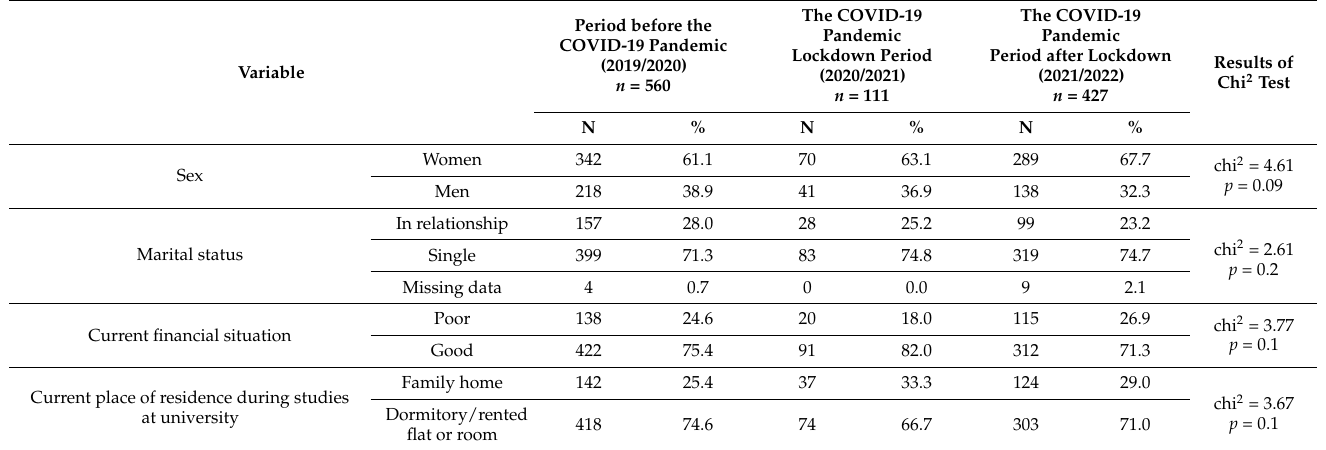
Table 1. Selected personal characteristics of the study groups and p -values of the Chi-square test. Period before the COVID-19 Variable